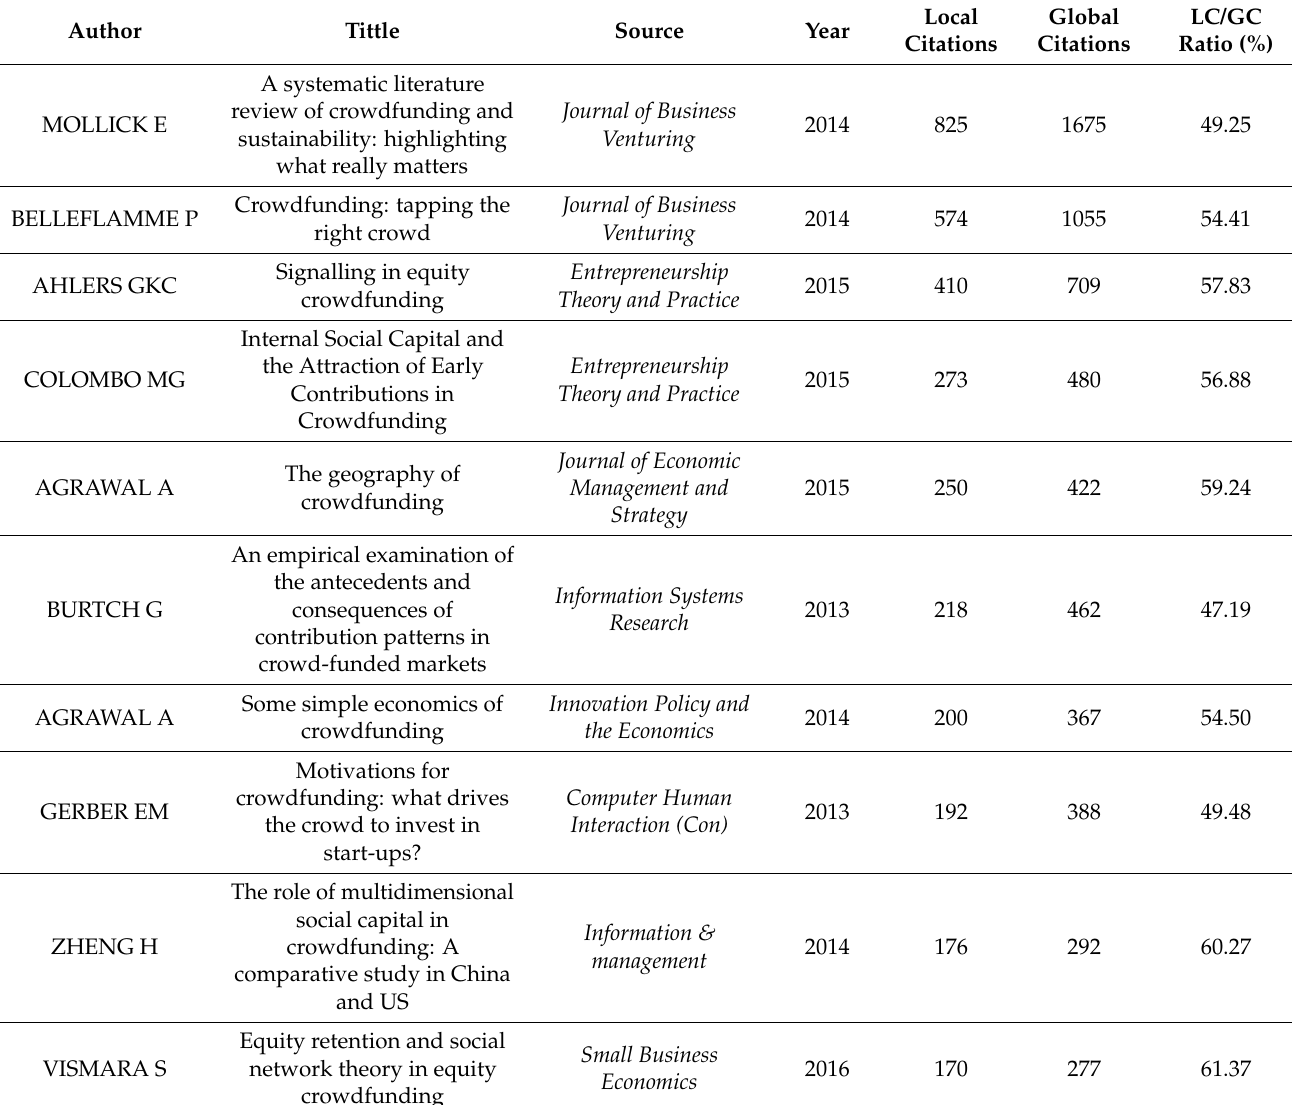
Table 4. The most influential